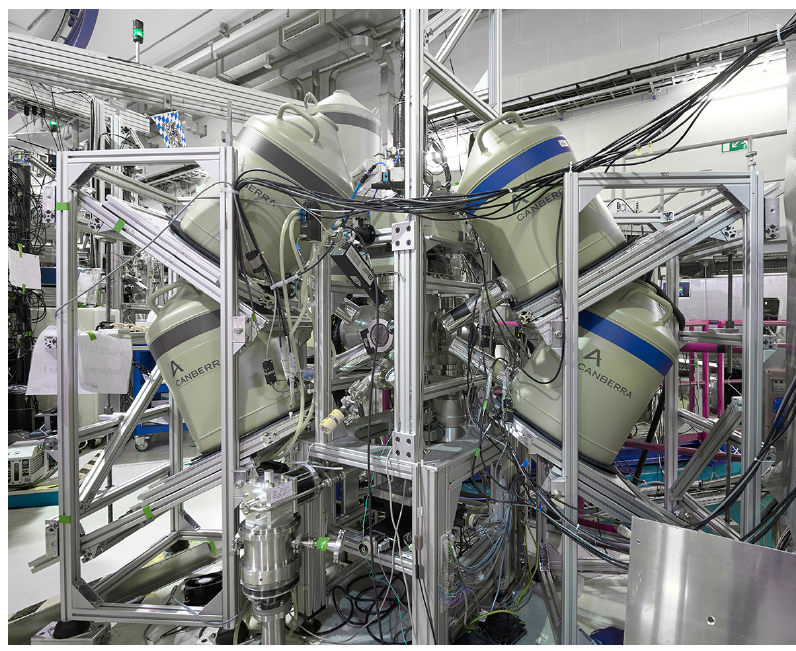
Figure 1: Instrument CDBS at NEPOMUC (Copyright by W. Schürmann,